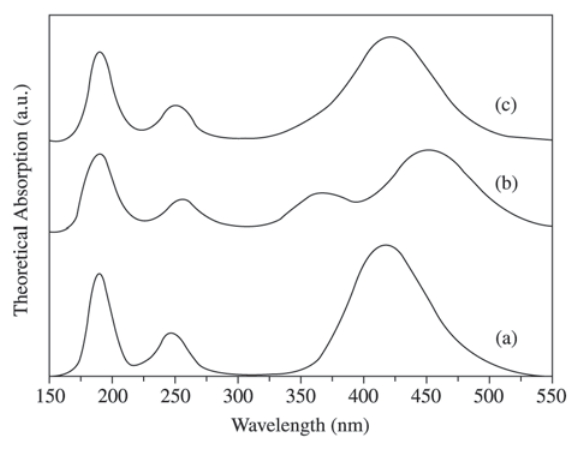
Figure 6. Theoretical absorption spectra . (a) CV + / CV + , (b) MG + / MG + and (c) CV + /MG + dimers in anti-parallel structure by INDO/ S-CI (absorption spectra) using the semiempirical method calcu- lated for optimized geometries.